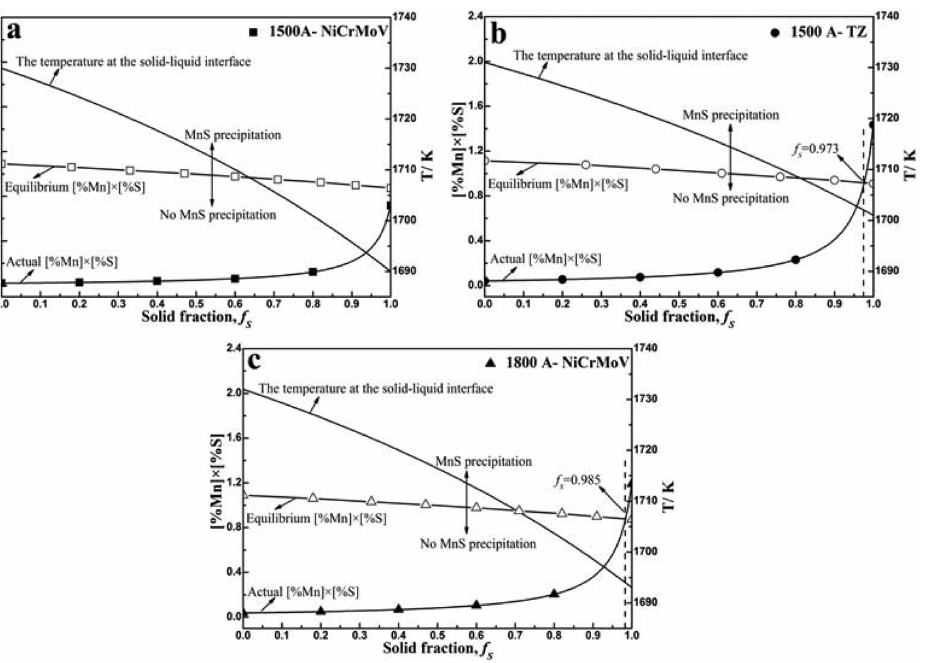
Figure 10: Relationship between concentration products of [Mn], [S] and solidification fraction: (a) specimen 1500 A-NiCrMoV, (b) specimen 1500 A-TZ, and (c) specimen 1800